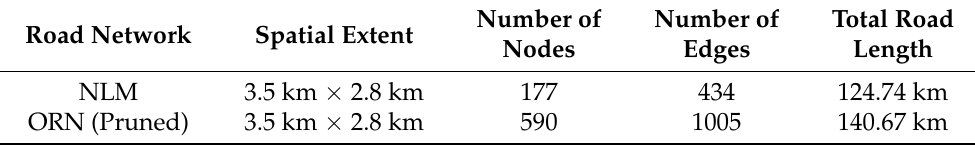
Table 4. Statistical description of NLM and ORN in